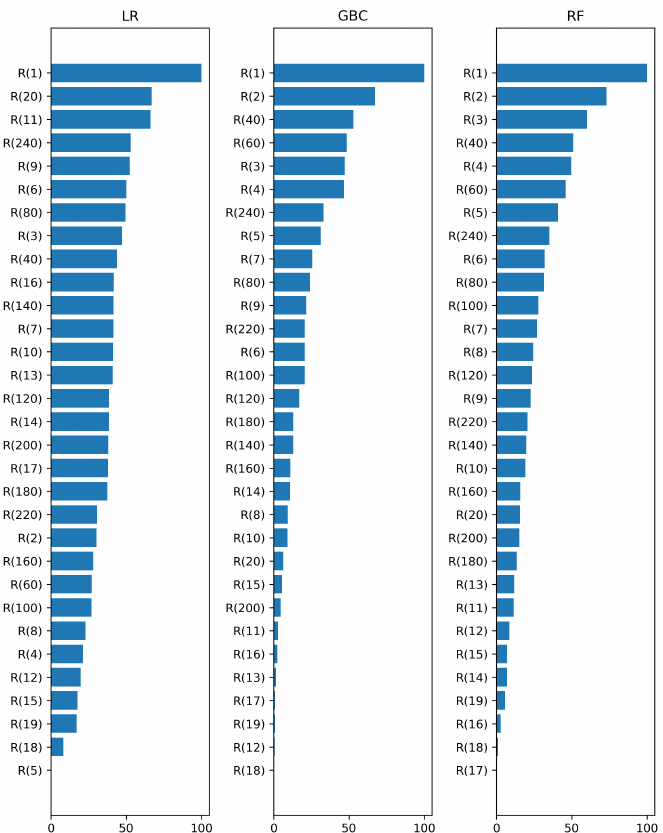
Figure 2. Feature importance. Average feature importance for the logistic regression (LR), gradient- boosting classifier (GBC) and random forest (RF). The most important feature is standardized to 100. Average feature importance is depicted for the top/flop three trading strategy ( k = 3 ) and a holding period of one day ( h = 1 )